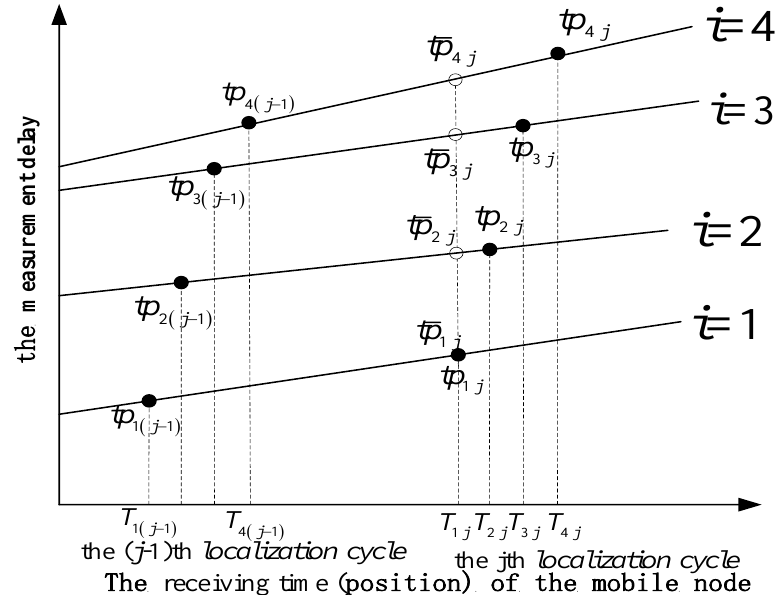
can interpolate the measurement delay of the mobile node at any position.